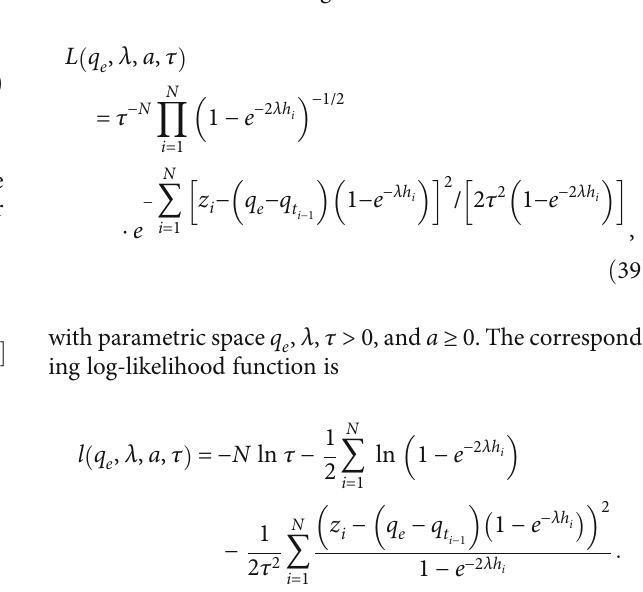
= 2 : 0 , n = 1 , k = 0 : 1 , and σ = 0 : 02 n e